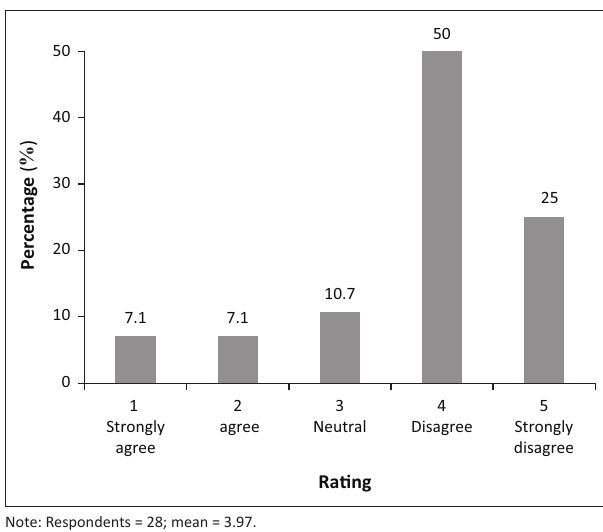
FIG URE 4: Black audit partners’ perspectives on